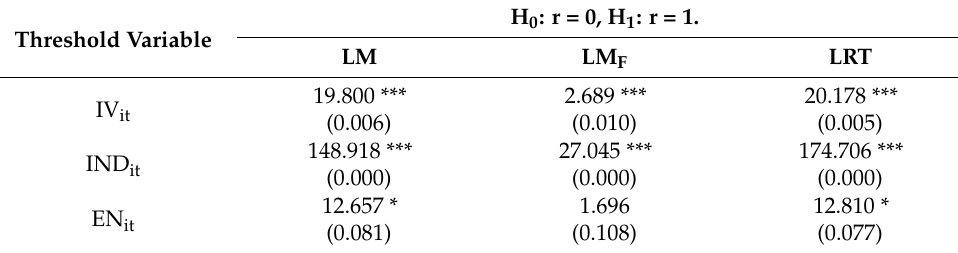
Table 4. Linear test.